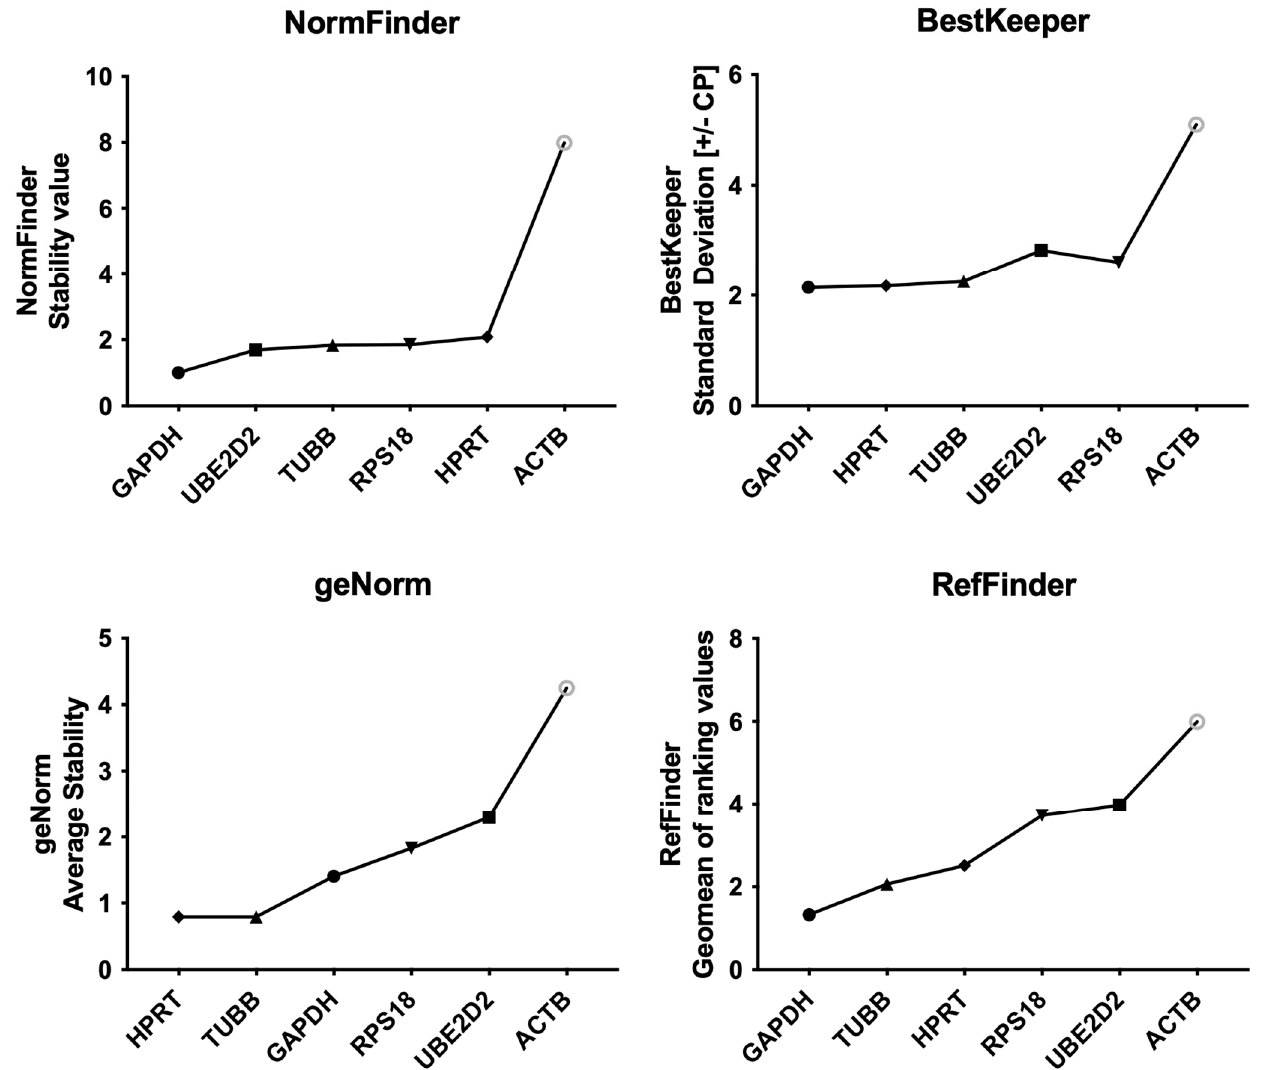
Figure 2. A comparison of results obtained via the RefFinder tool. The most stably expressed genes are represented by lower values obtained by three algorithms: NormFinder, BestKeeper, geNorm, and a comprehensive ranking of all algorithms together with the comparative Delta-Ct method using